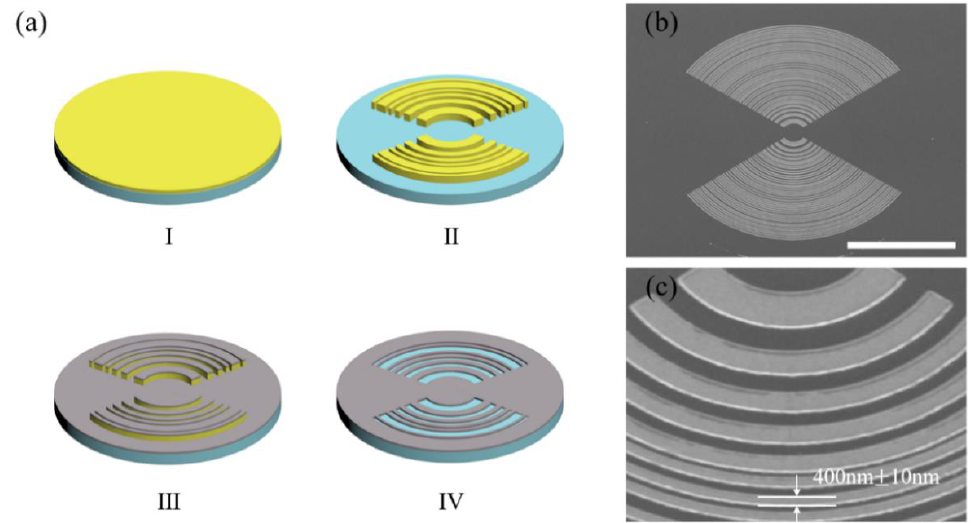
Figure 3. Schematic representation of the fabrication procedure. ( a ) The fabrication process of elliptical SCL: (I) spin coating with PMMA a4; (II) EBL patterning; (III) Ti Evaporation; (IV) lift off; ( b ) the SEM image of processing structure. Scale Bar: 50 μ m; ( c ) the sectional zoom-in view of the elliptical SCL.